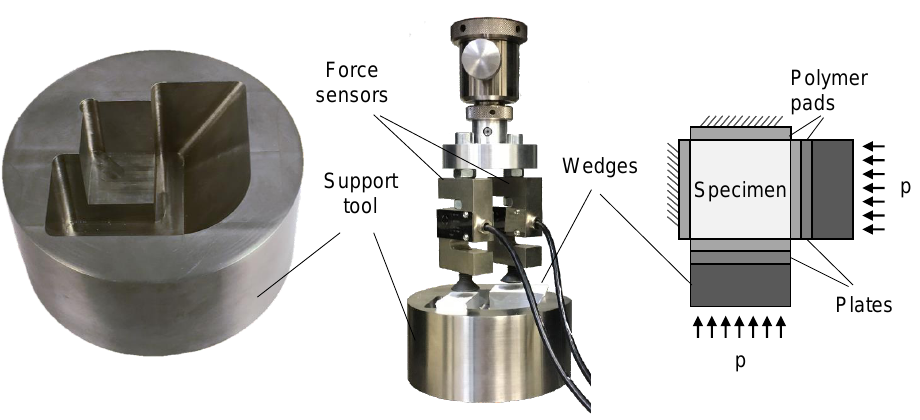
Figure 6. Test setup for bi-axial compression experiments on a universal testing